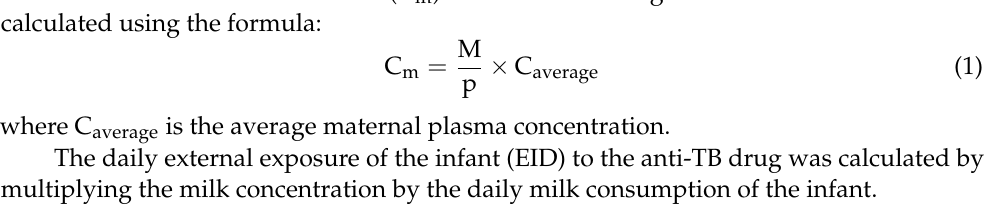
Table 1. Overview on (A) number of articles found in the search, (B) number of articles remaining after title and abstract screening and (C) number of articles remaining after full text screening.